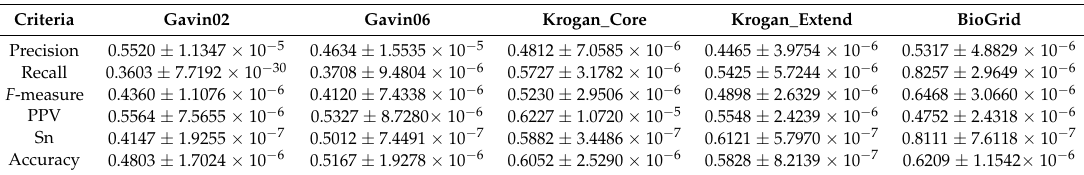
Table 6. Performance of seed-expansion graph clustering (SEGC) on data